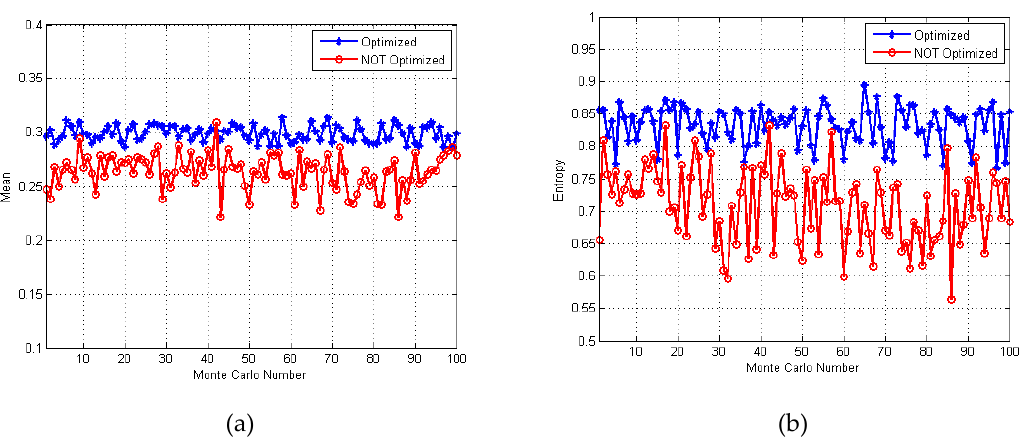
Figure 21. Monte Carlo results of MPSM jamming for the optimized section situation and the phase situation: ( a ) mean values and ( b ) entropy values.